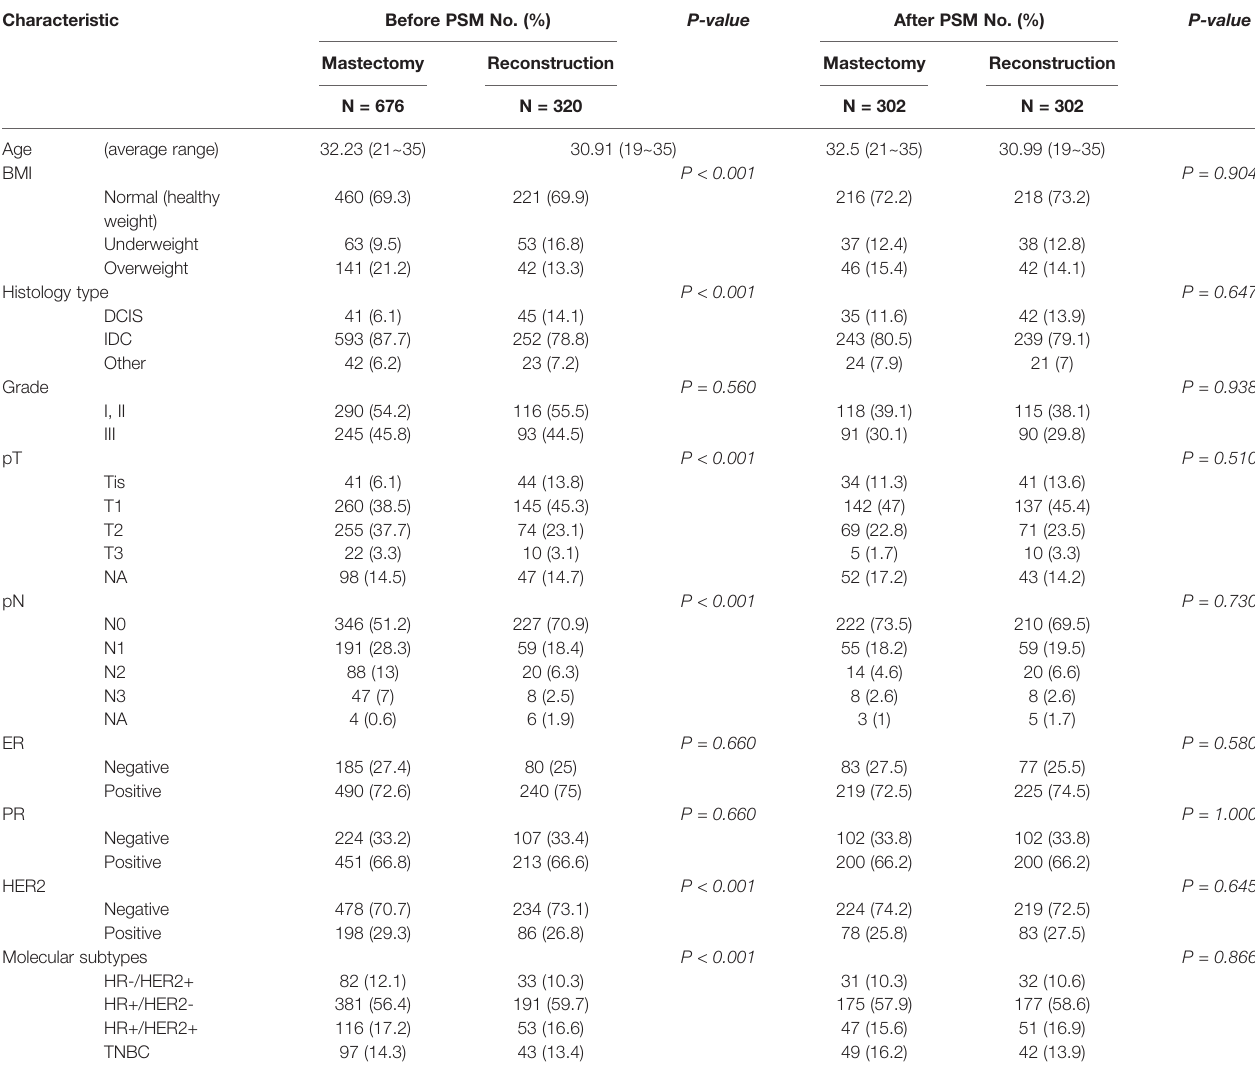
TABLE 3 | After propensity score matching, the baseline characteristics of reconstruction after total mastectomy vs. mastectomy alone. Characteristic Before PSM No.